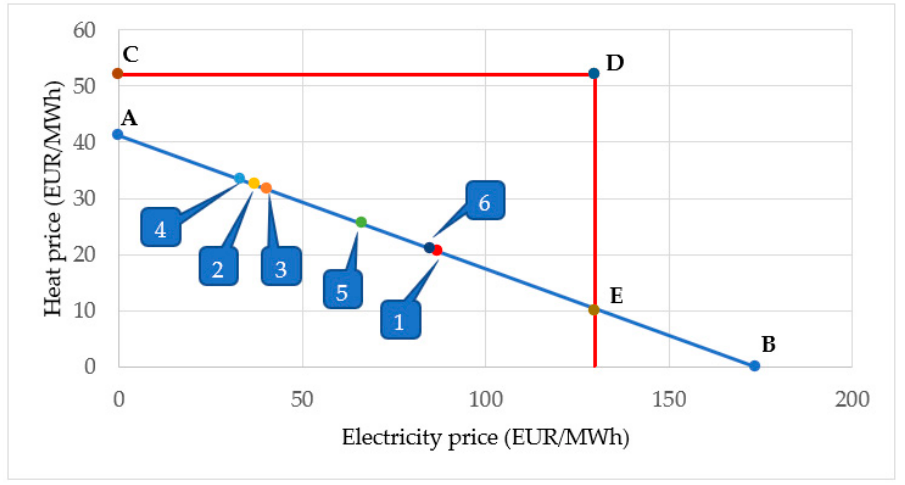
Figure 5. Heat and electricity tariffs that balance the total